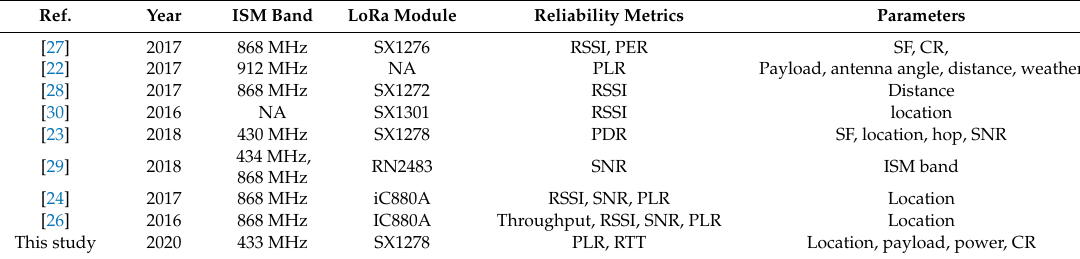
Table 4. Comparative analysis of